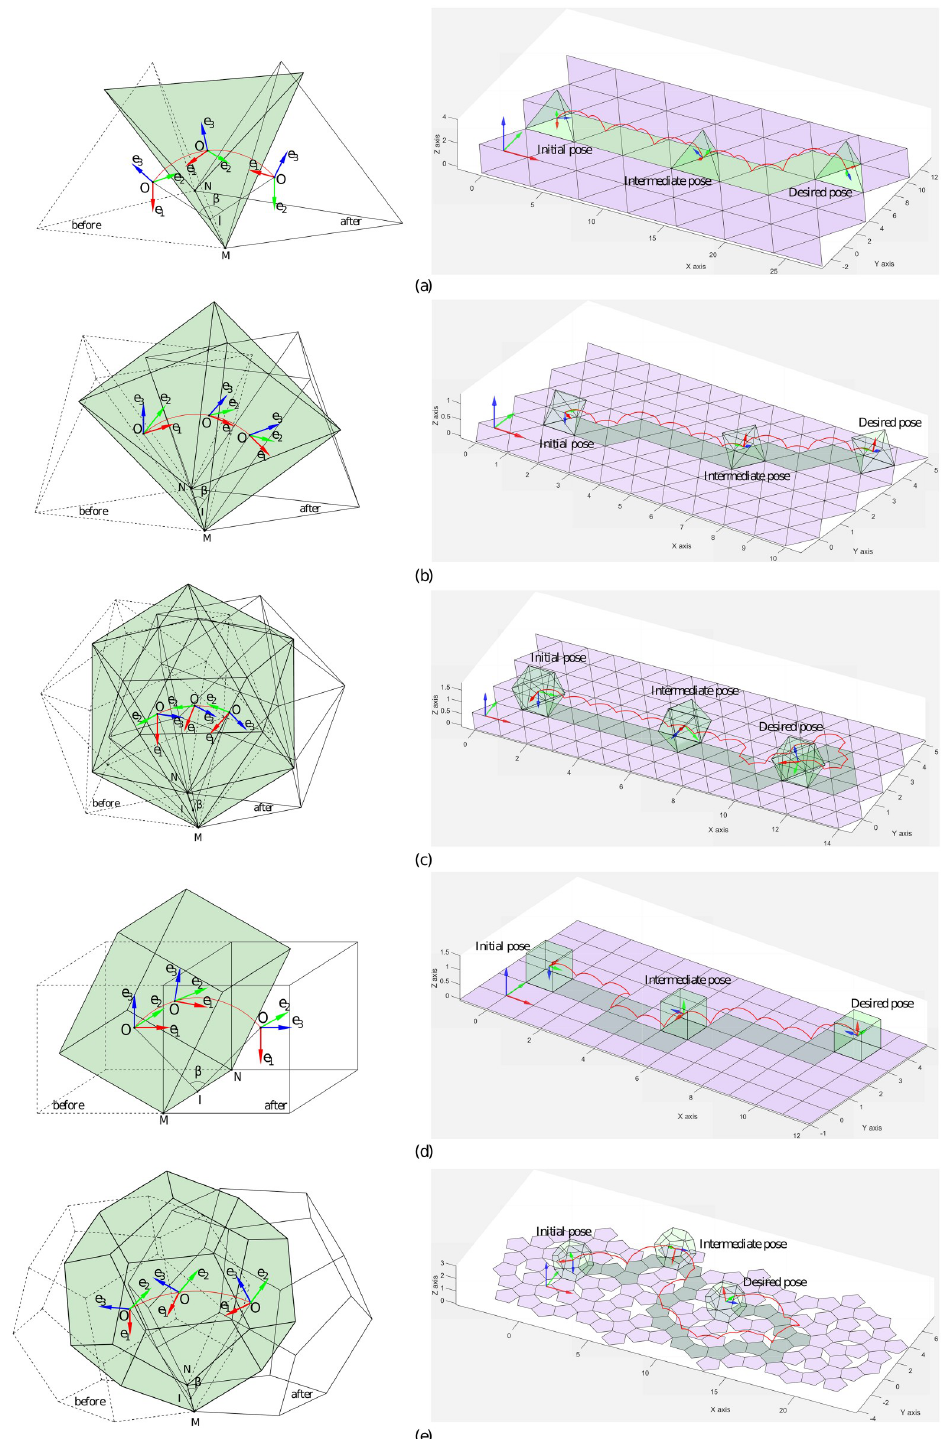
Fig 6. Platonic solids rolling through their edge MN withdifferent rotation angles shown in Table 2. A body frame ( O − e 1 e 2 e 3 ) is fixed at the center of each solid (left). After edge-rolling, each Platonic solid reaches a new pose, where the red curve represents the center’s trajectory of rolling. Path-planning results for the Platonic solids on a plane shown in the right side. (a) Tetrahedron. (b) Octahedron. (c) Icosahedron. (d) Cube. (e) Dodecahedron.